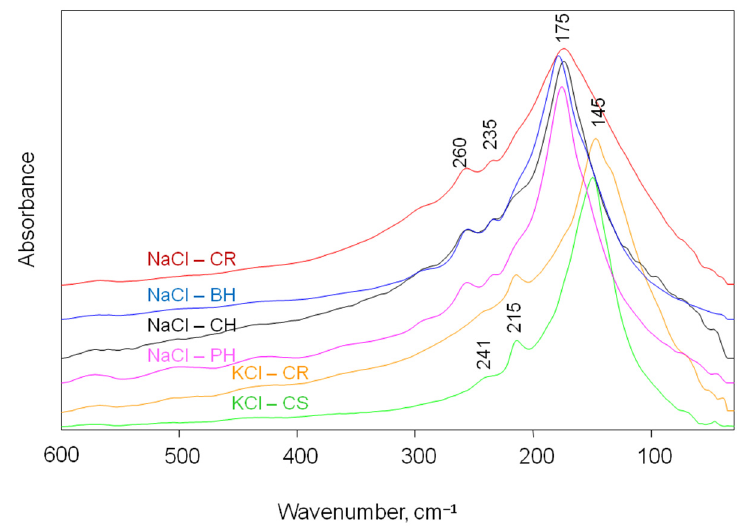
Figure 4. The experimental far infrared spectra in the range of 600–30 cm − 1 of NaCl and KCl: ―― NaCl-CR—NaCl analytical pure chemical reagent, ―― NaCl-BH—blue halite, ―― NaCl-CH—colorless halite, ―― NaCl-PH—purple halite, ―― KCl-CR—KCl analytical pure chemical reagent, ―― KCl-CS—colorless sylvite.